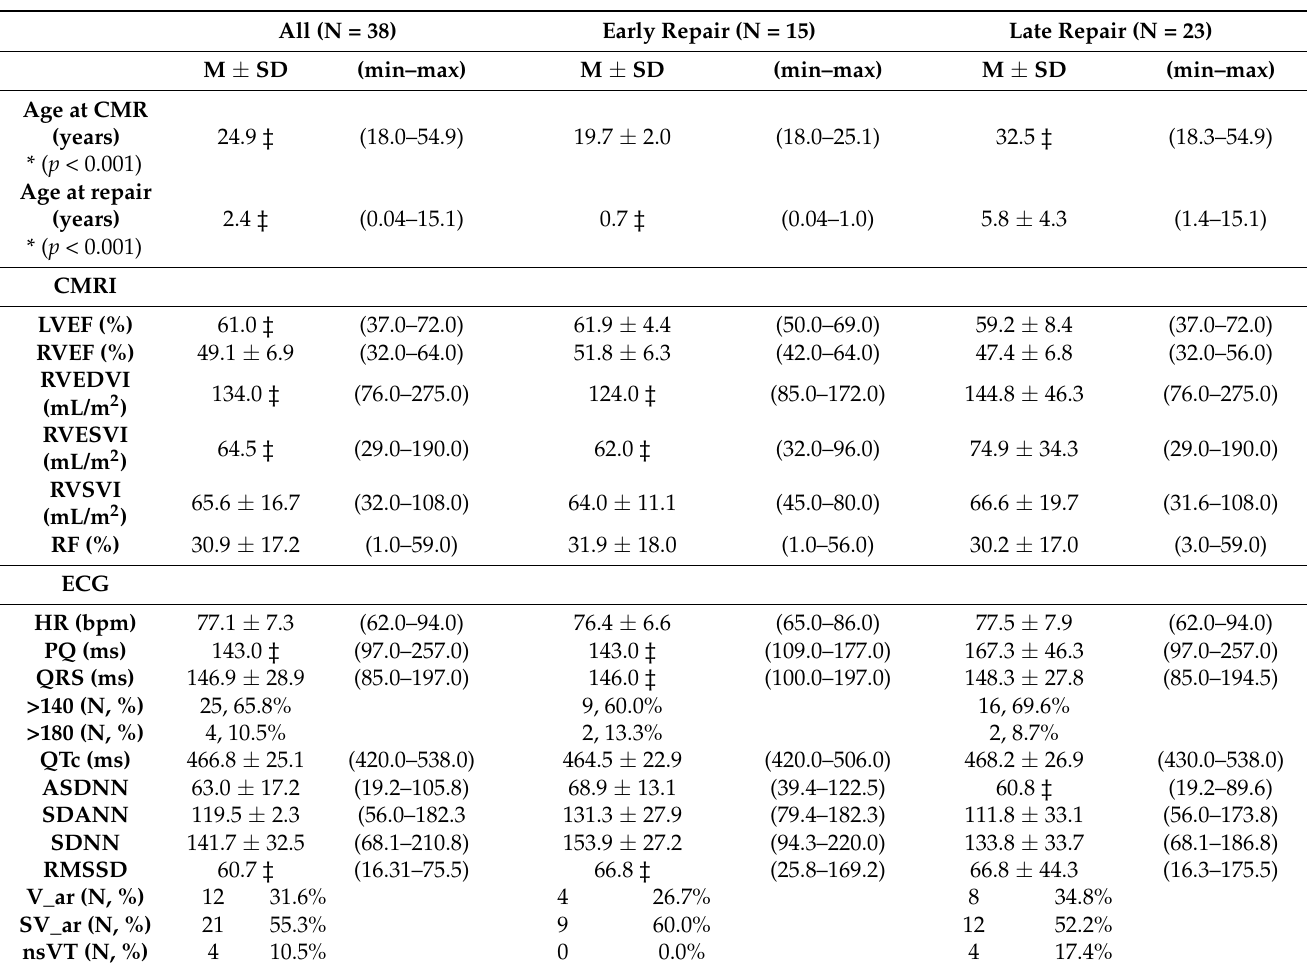
Table 2. Descriptive characteristics of the population. For variables which were not normally distributed (‡), the median was given instead of mean and standard deviation; * = significant difference between patients after early and late repair. CMR—cardiac magnetic resonance; LVEF—left ventricular ejection fraction; RVEF—right ventricular ejection fraction; RVEDVI—right ventricular end-diastolic volume index; RVESVI—right ventricular end-systolic volume index;